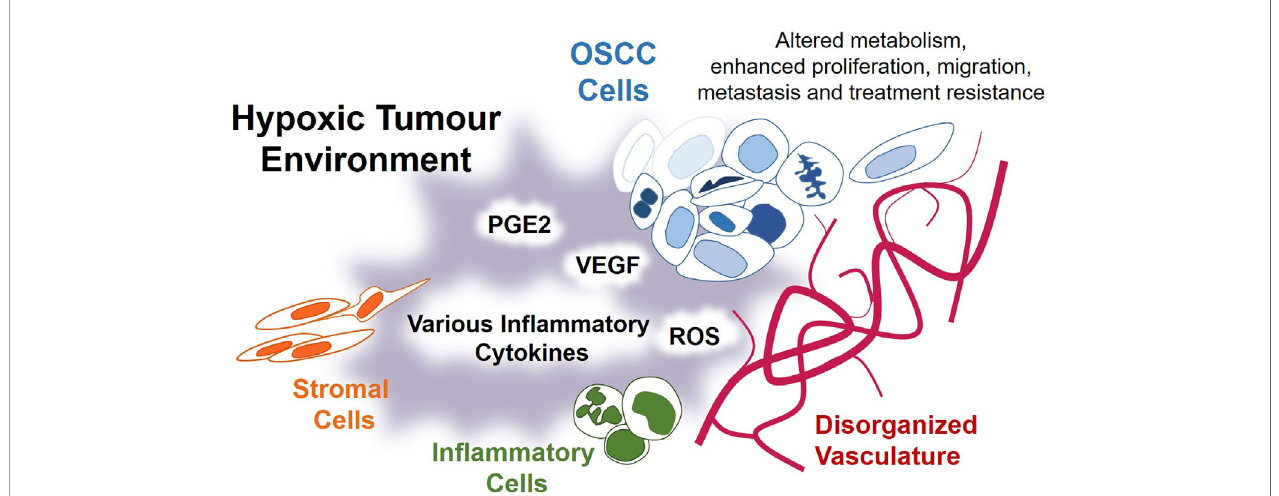
FIGURE 2 | Introduction to hypoxia and in fl ammation in OSCC. OSCC tumours are composed of a variety of cell types, which include vascular endothelial cells, in fl ammatory and immune cells, stromal cells, and OSCC tumour cells. This literature review explores the relationship between hypoxia and in fl ammation in OSCC tumours, as well as how this relationship contributes to disease progression. Key products of this relationship include in fl ammatory PGE2 (prostaglandin E2), angiogenic VEGF (vascular and endothelial growth factor), ROS (reactive oxygen species). Throughout this literature review, mechanisms leading to the synthesis of these factors will be described, with emphasis on how these mechanisms interact and overlap. An understanding of these interactions is important to the process of developing new therapeutic strategies for OSCC in humans and in